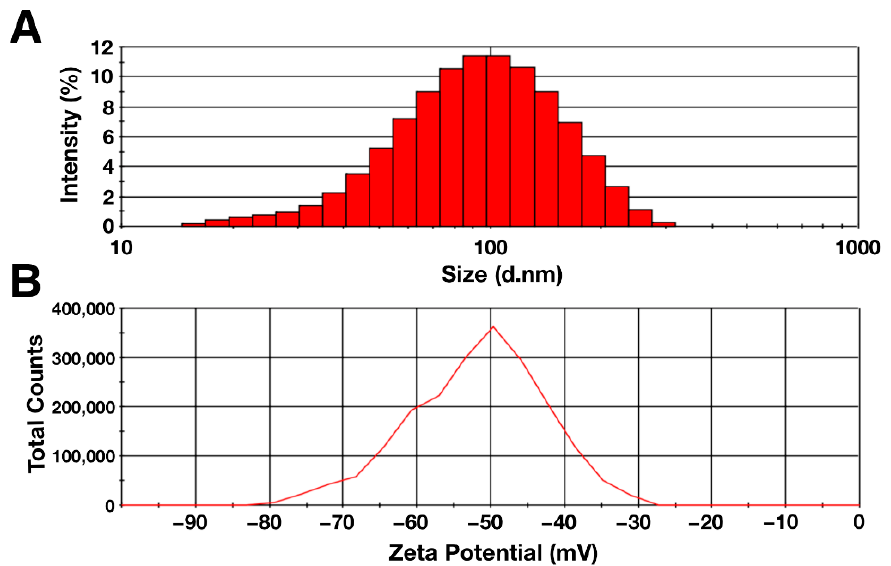
Figure 2. ( A ) Hydrodynamic diameter and ( B ) zeta potential of citrate-stabilized magnetic nanoparticles (0.1%).